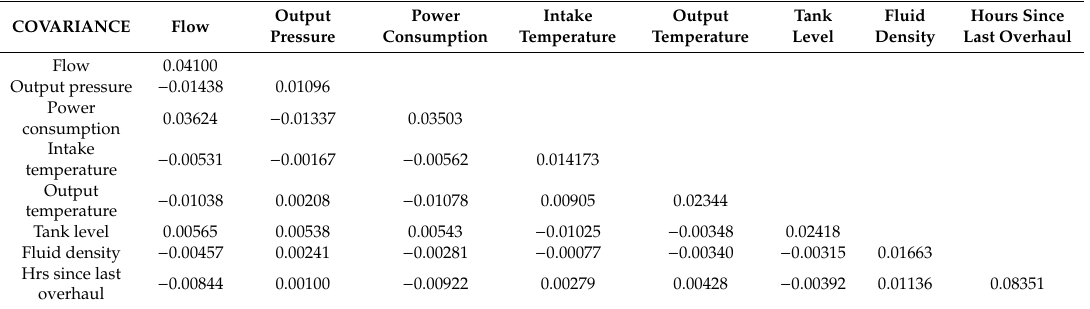
Sample covariance matrix and correlation coe ffi cients, to identify the dependence between